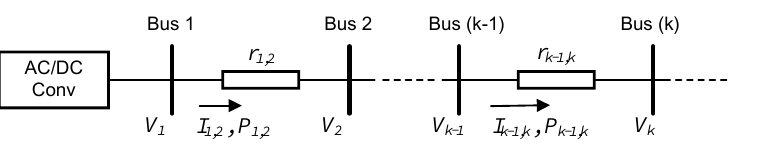
Figure 9. Power system parameters in LVDC radial distribution system.